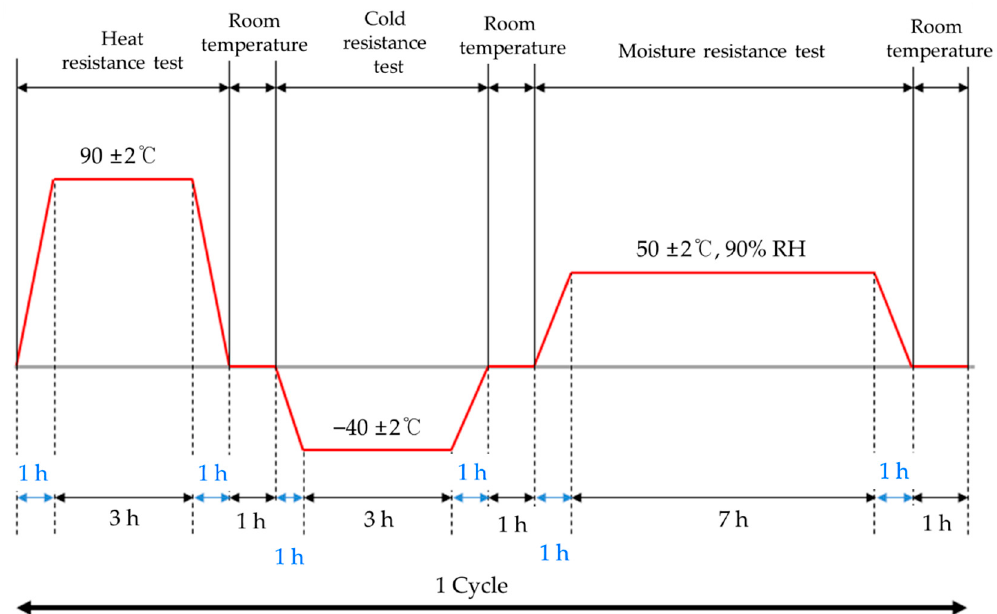
Figure 15. Heat-resistant cycle profile applied for verifying functional reliability of headliner.